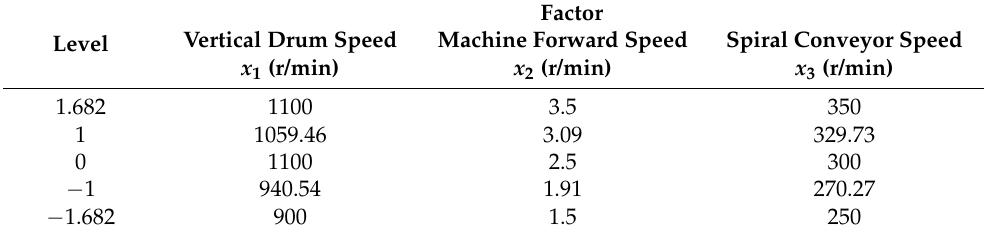
Table 5. Experiment design and response